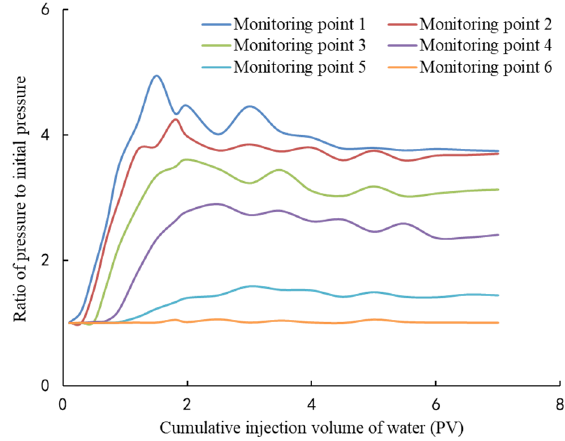
Figure 8. Pressure changes at each monitoring point for model No. 2 after plugging.